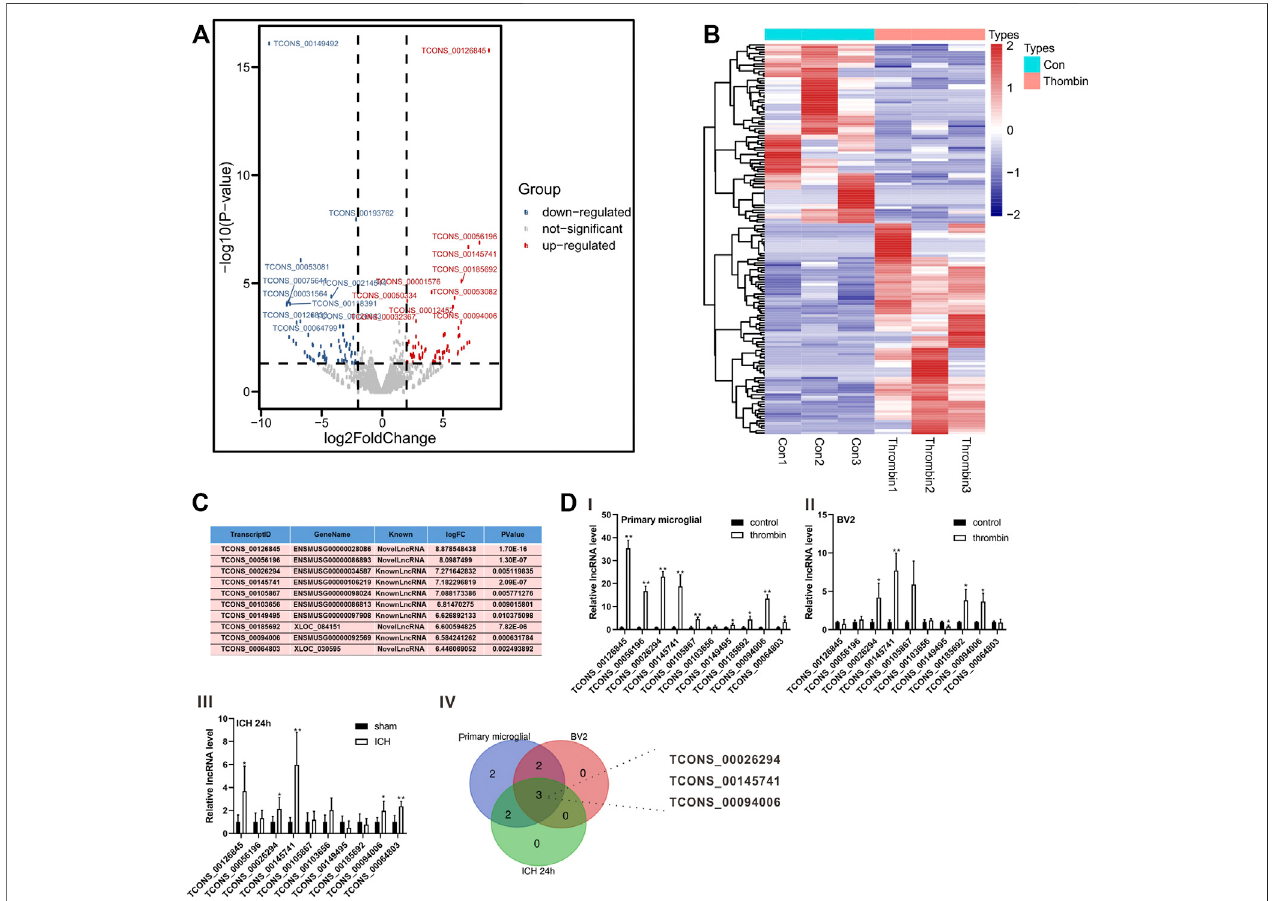
FIGURE 2 | Expression pro fi les of lncRNAs induced by thrombin in primary microglia. (A) The Scatter plot compiled differentially expressed lncRNAs between the thrombingroupandthecontrolgroup. (B) Hierarchicalclusteringanalysisofthedifferentiallyexpressed lncRNAsbetweenthethrombingroupandthecontrolgroup. (C) The top 10 up-regulated lncRNAs with the highest fold change between the thrombin group and the control group. (D) Detection of the above 10 differential lncRNAs in thrombin-treated primary microglia, thrombin-treated BV2 cells, and the ipsilateral coronal area of the ICH 24 h group by quantitative real-time PCR (qRT-PCR). * p < 0.05, ** p < 0.01 vs. control or